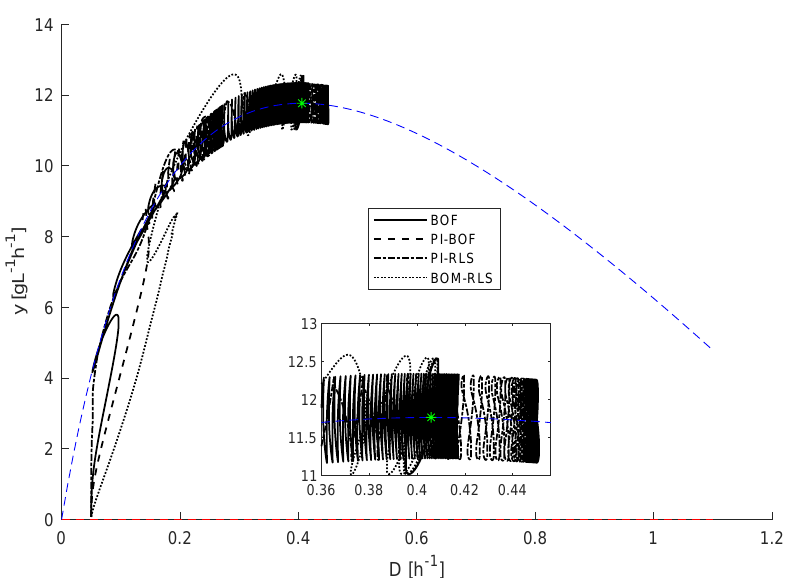
Figure 13. Application of the BOF, PI-BOF, PI-RLS, and BOM extremum seeking methods to optimize biomass productivity of microbial growth represented by model (3) with Contois kinetics—convergence